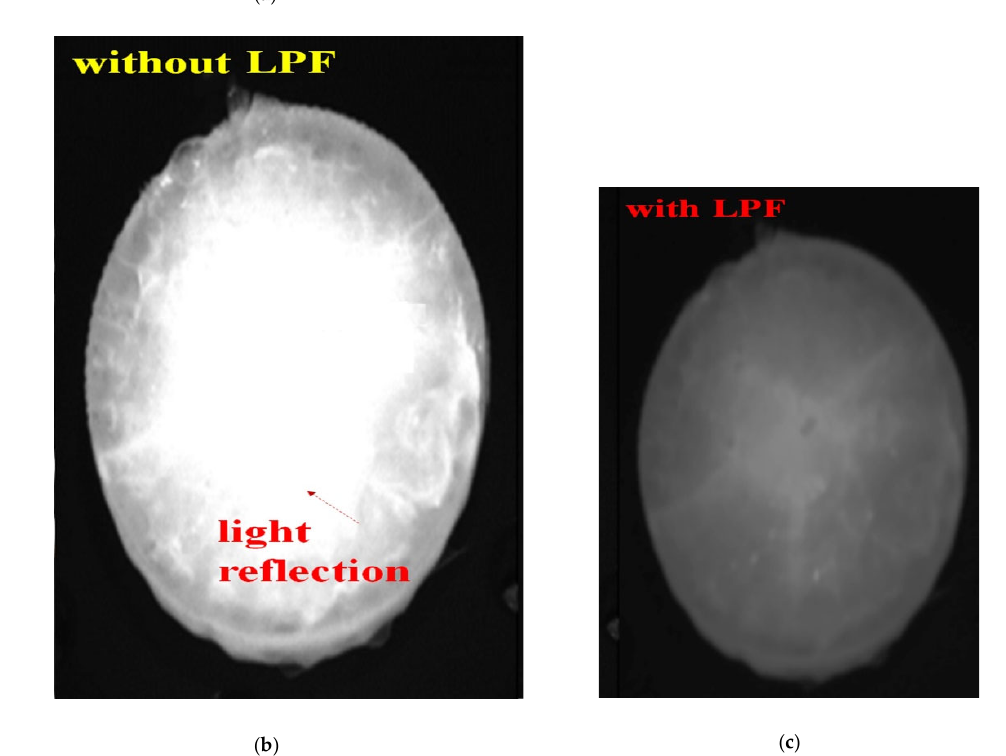
Figure 18. Laser applications ( a ) test configuration ( b ) without LPF ( c ) with LPF.